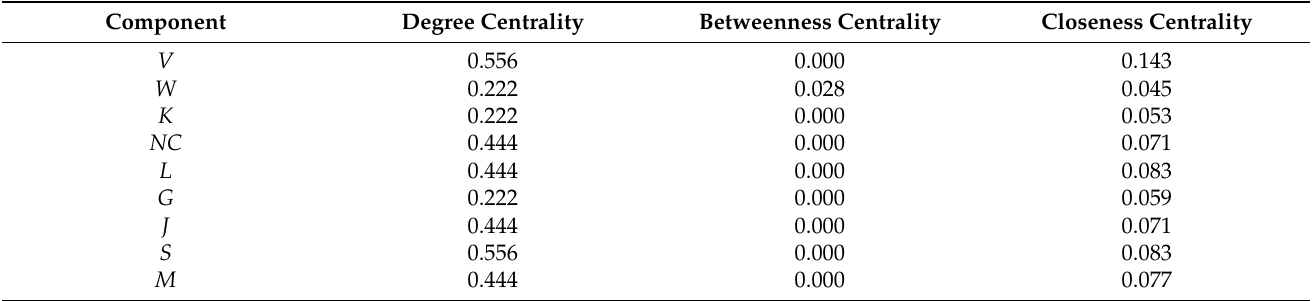
Figure 10. Transformation of ANP model of machining center into topological structure model. According to Figure 10b, the machining center topology model and Equations (4)–(7), the degree centrality, betweenness centrality and closeness centrality of the nodes in the machining center component topology model can be calculated, as shown in Table 9. Table 9. Centrality measure of machining center component nodes. Betweenness Centrality